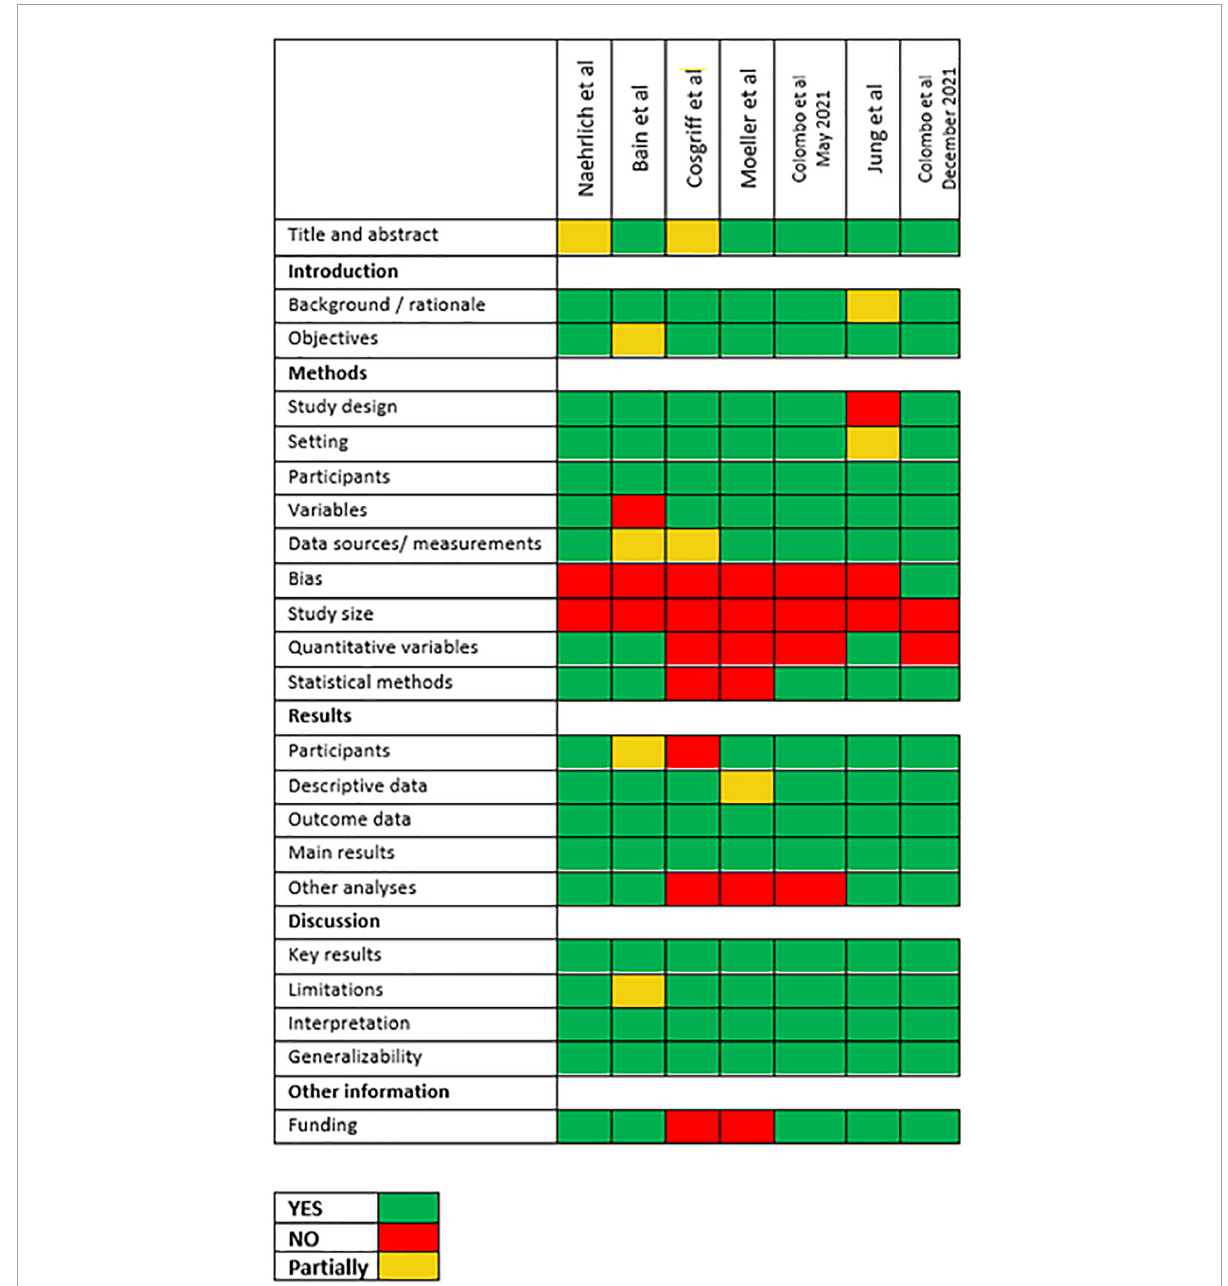
FIGURE1 Adherence of selected studies to STROBE recommendations.